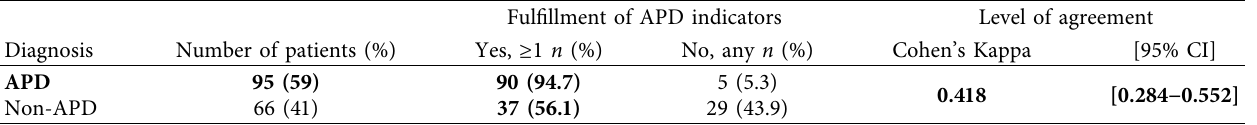
Table 5: Overall agreement between APD diagnosis and fulfillment of APD indicators. Fulfillment of APD